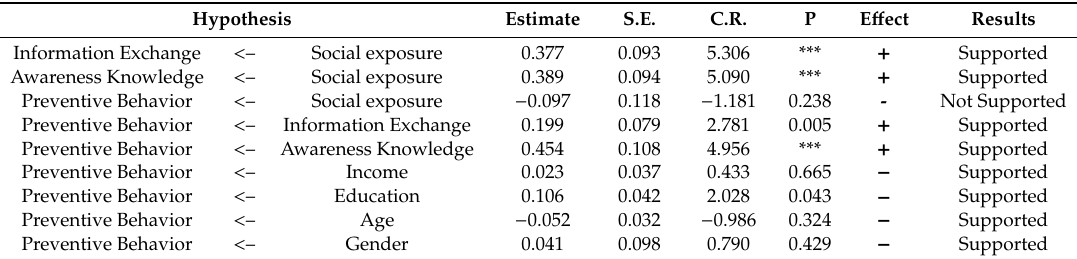
Table 4. Regression weights (group number 1—Default